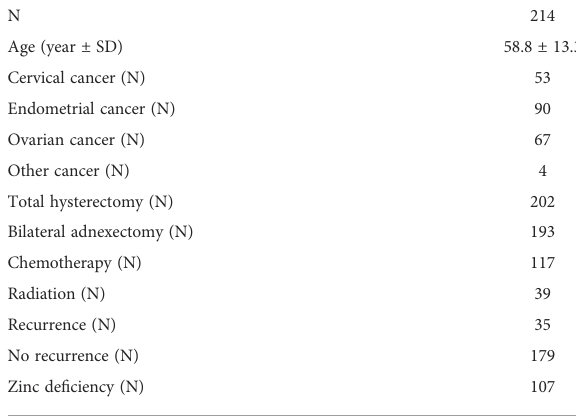
TABLE 3 Breakdown of patients with cancer included in the